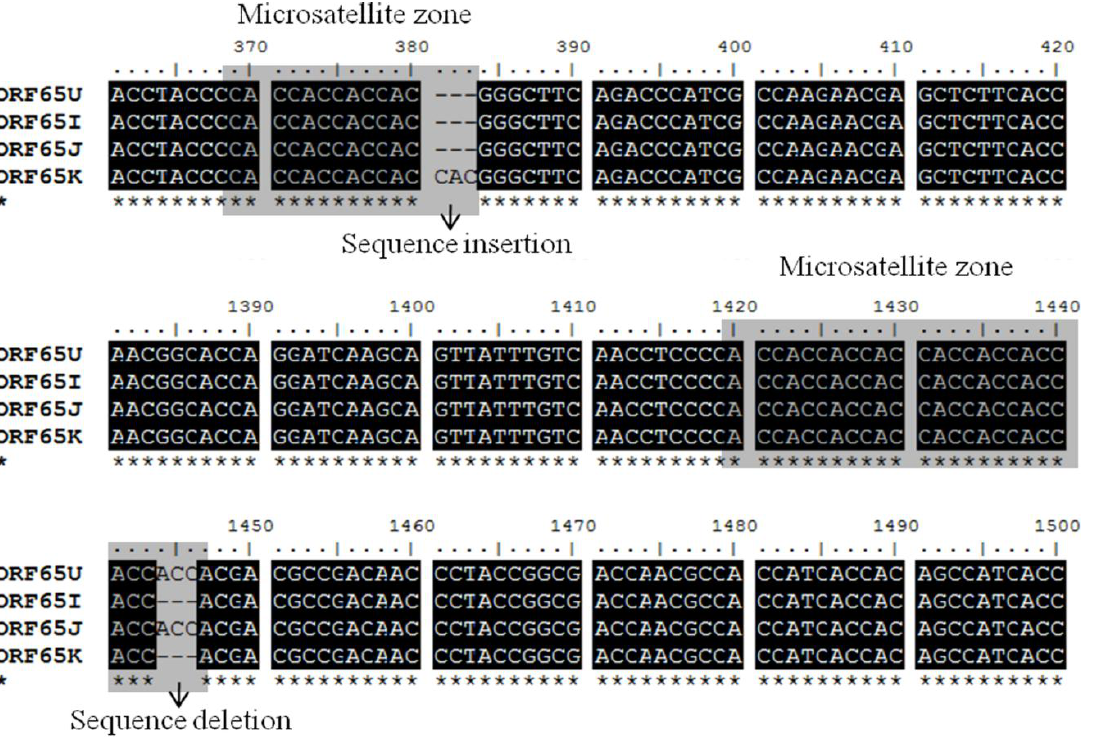
Figure 2. Nucleotide sequences of the glycoprotein gene (open reading frame [ORF]65) of Korean CyHV-3 (KHV-K) and those of the USA (KHV-U), Israel (KHV-I), and Japan (KHV-J) CyHV-3 were aligned using BioEdit software. Two microsatellite zones were observed, and both sequence insertions and deletions were observed in KHV-K.